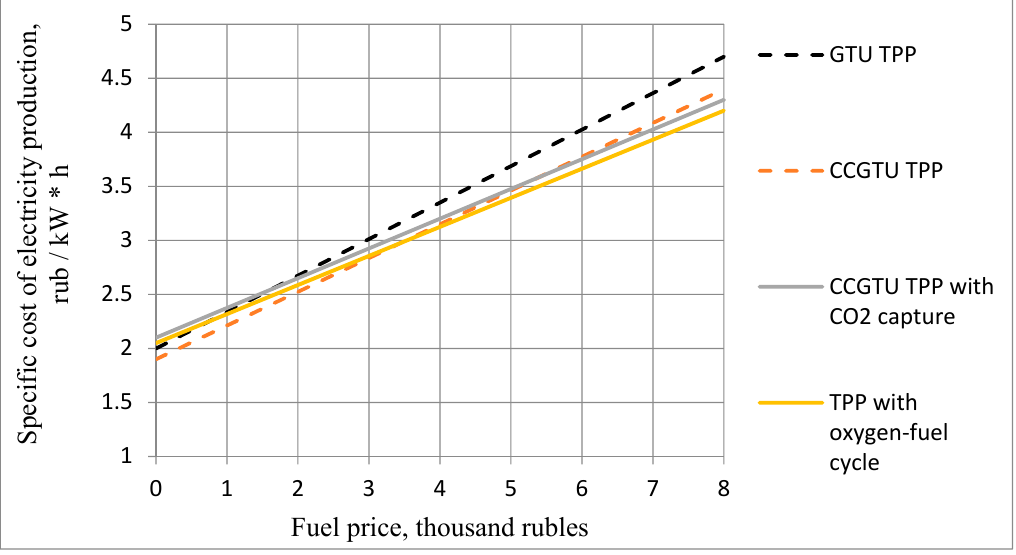
Figure 5. Dependence of the unit cost of electricity production on the price of fuel for the conventional and oxygen combustion, taking into account quotas for the greenhouse gas emissions.